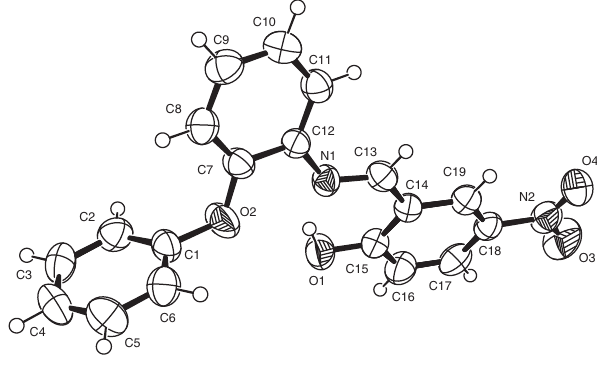
Table 1: Data collection and